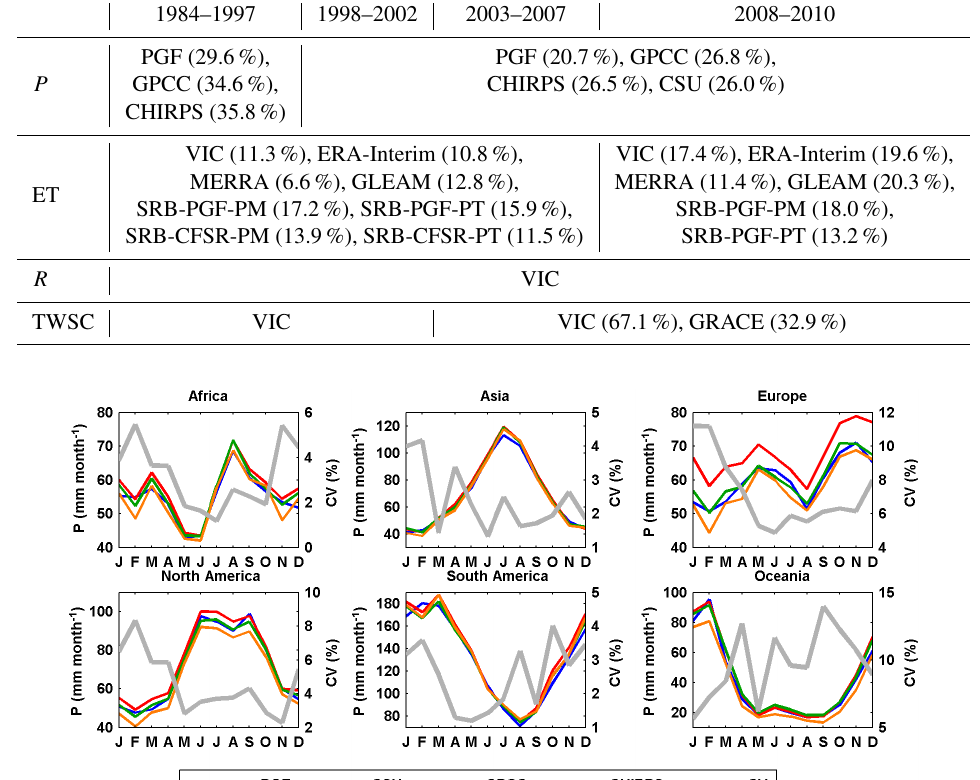
Table 2. Data sources of merged water budgets with their averaged merging weights in brackets throughout different subperiods (TWSC from GRACE in 2002 is incomplete, so GRACE for 2002 is excluded; the spatial maps of merging weights over the globe can be found in Figs. S1 to S3 in the Supplement II).